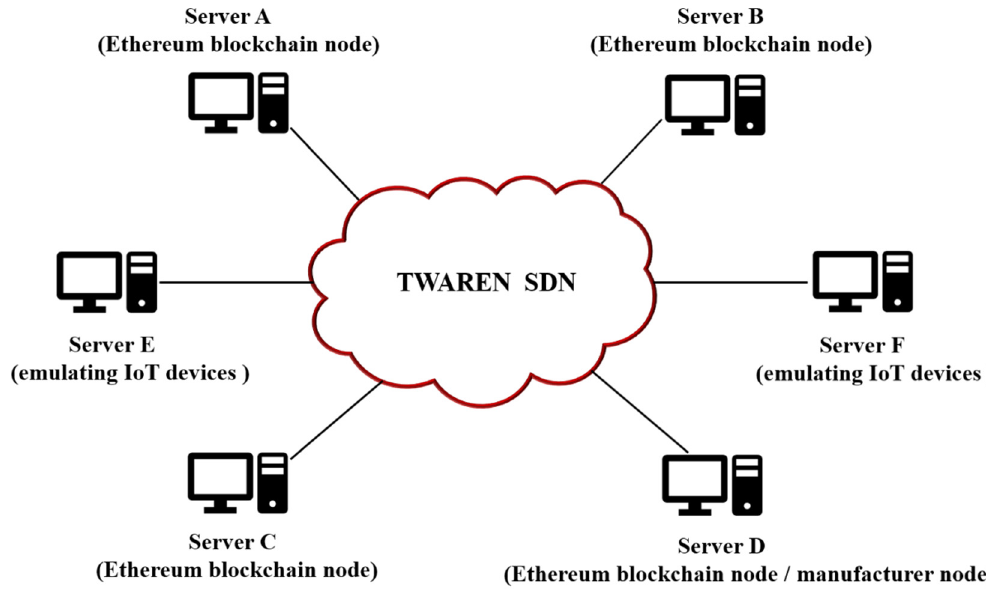
Figure 6. The network topology of experiment for the proposed system.